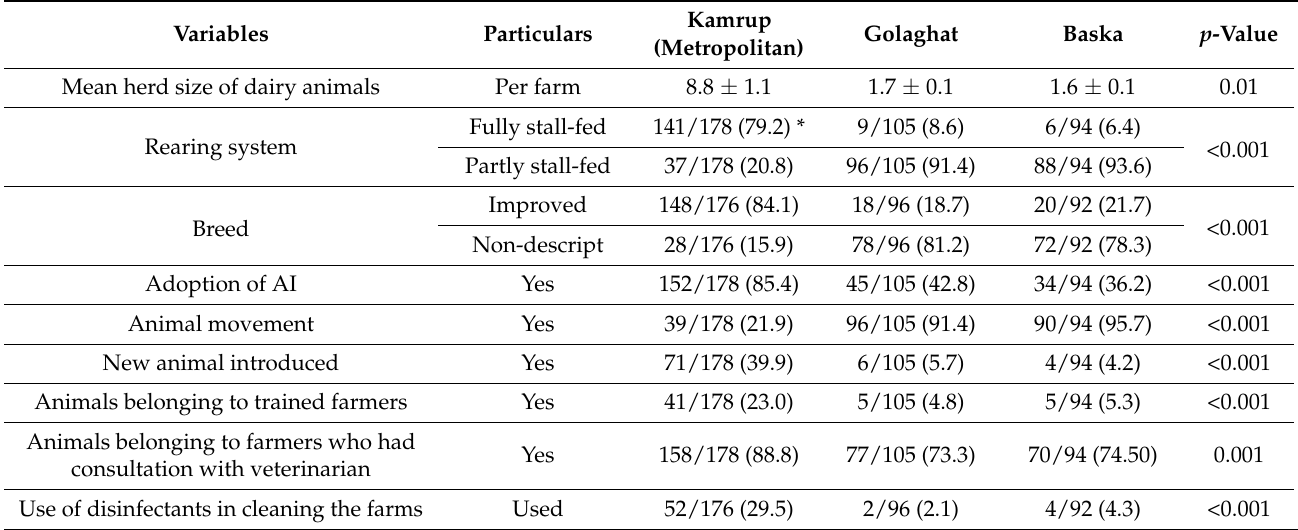
* Figure in the parenthesis indicates percentage of the corresponding